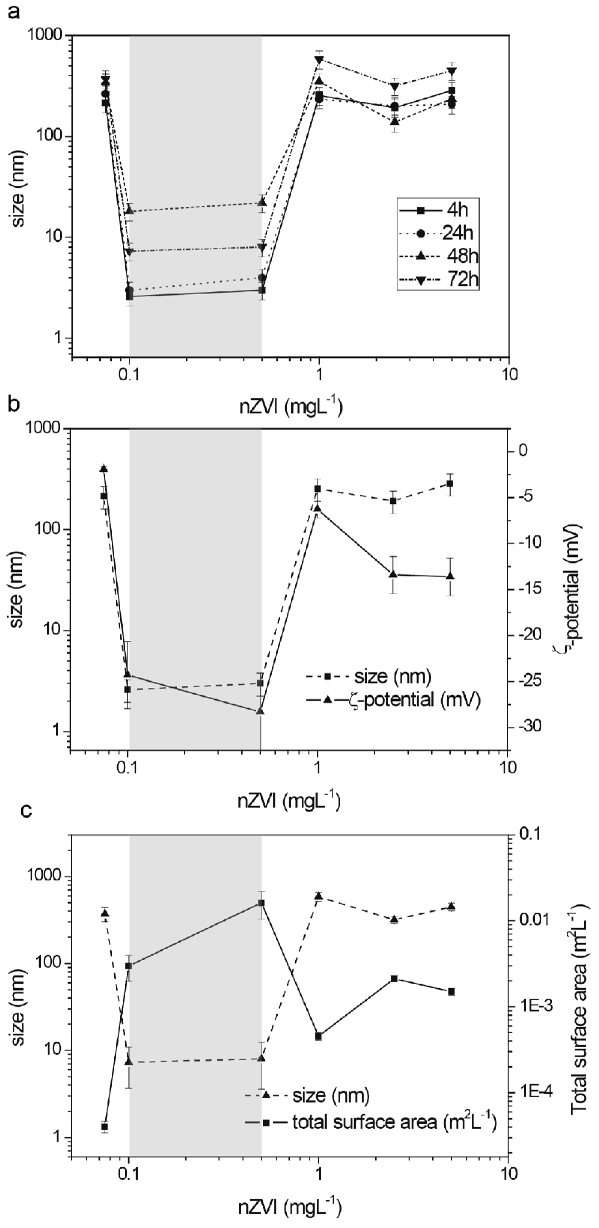
Figure 2. The occurrence of a colloidal singularity : Main physicochemical characteristics of colloidal nZVI fractions under experimental conditions. (a) Particle size of a range of nZVI concentrations at 4 h, 24 h, 48 h and 72 h. (b) f -potential and particle size for a representative exposure time (4 h). (c) Total surface area (m 2 L 2 1 ) and particle size for a representative exposure time (4 h). The concentration range in which the colloidal singularity occurred is marked in blue.